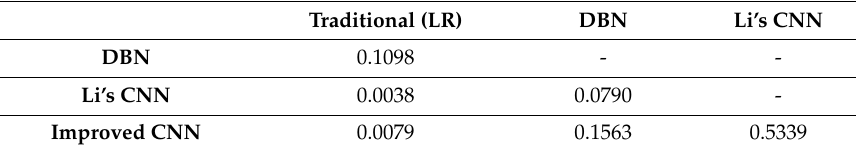
Table 5. Holm–Bonferroni test of prediction on the SPSC